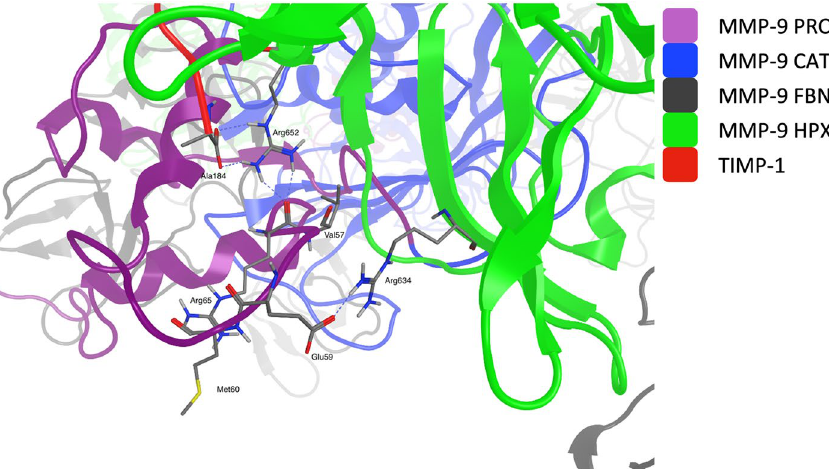
Figure 3. The proMMP-9 bait region in the circular heterohexamer. Propeptide (purple) Glu59 forms an electrostatic interaction with HPX (green) Arg634, which stiffens the bait region, making it less accessible for the MMP-3 molecule. The Val57 residue, which is supposed to fit into the MMP-3 S3 site during MMP-9 activation, is buried deep inside the structure of the MMP-9 homotrimer. TIMP-1 C-terminal Ala184 forms a double hydrogen bond and interacts electrostatically with Arg652 of the hemopexin